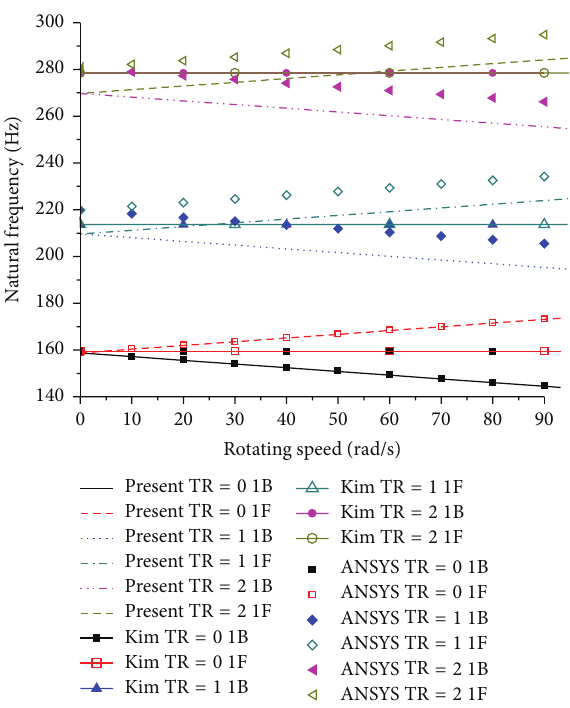
Figure 6: Changes comparison with rotating speed ( 𝜃 = 0 ∘ ).